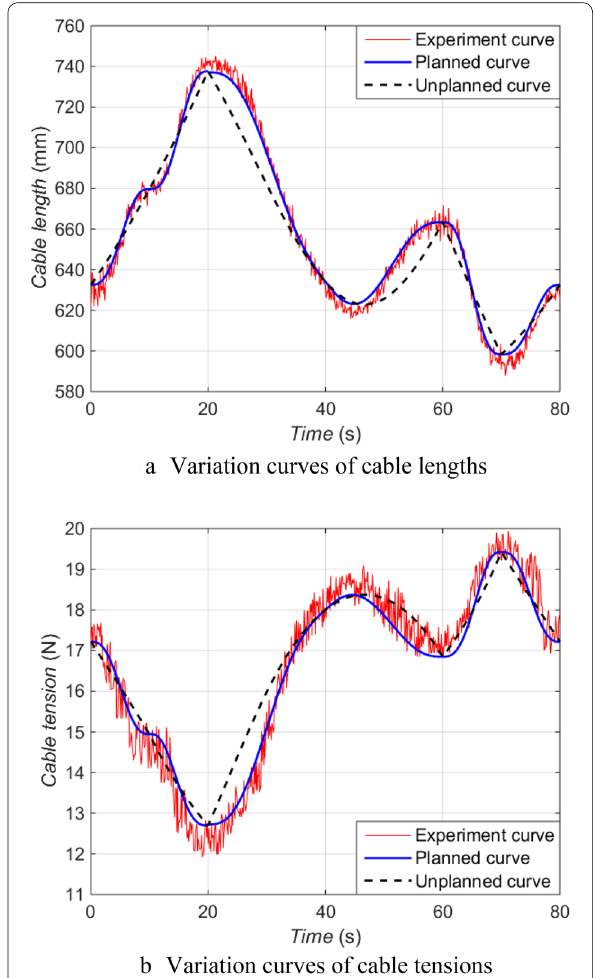
Figure 20 Variation curves of lengths and tensions of cable 3